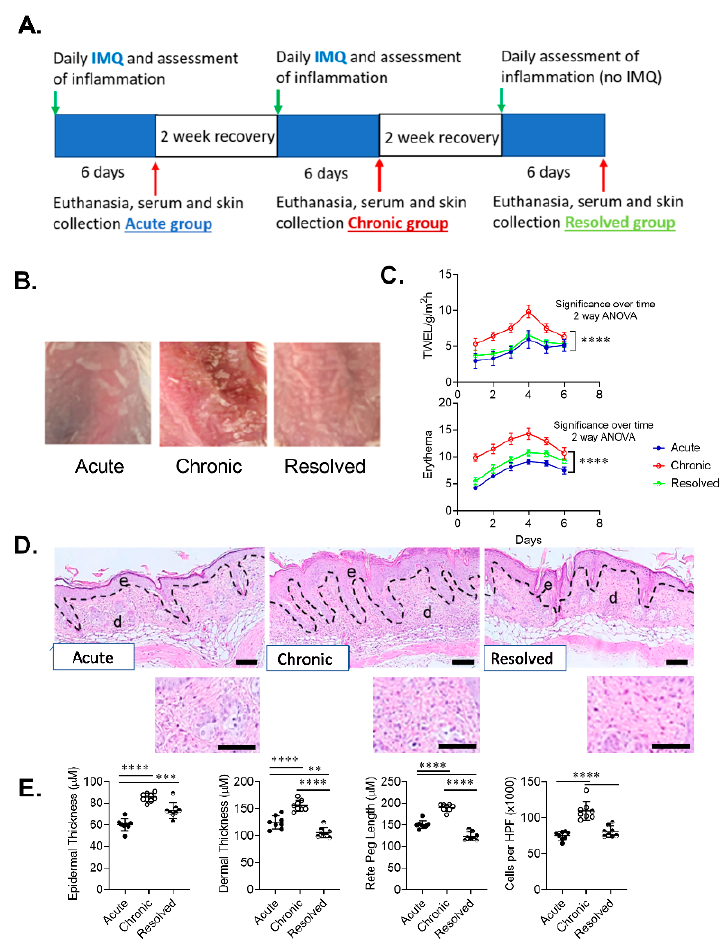
Figure 2. Development of imiquimod-induced acute, chronic and resolved psoriasis-like dermatitis in mice skin. ( A ) Model timeline. ( B ) Representative macroscopic images of developed imiquimod-induced psoriasis-like dermatitis. ( C ) Graphical analysis of transepidermal water loss (TEWL) and erythema measurements in mice with acute, chronic and resolved psoriasis-like dermatitis. ( D ) Representative sections of psoriasis-induced mice skin stained with hematoxylin and eosin (scale bar = 100 µm, inset scale bar = 25 µm). ( E ) Graphical analysis of psoriasis-like mouse skin in acute, chronic and resolved groups comparing histological changes including epidermal thickness, rete peg length, dermal thickness and a total number of inflammatory cells per high-power field (HPF) (original magnification ×1000). Data are presented as mean ± SD. n = 8/group. ** p < 0.01, *** p < 0.001, **** p < 0.0001.